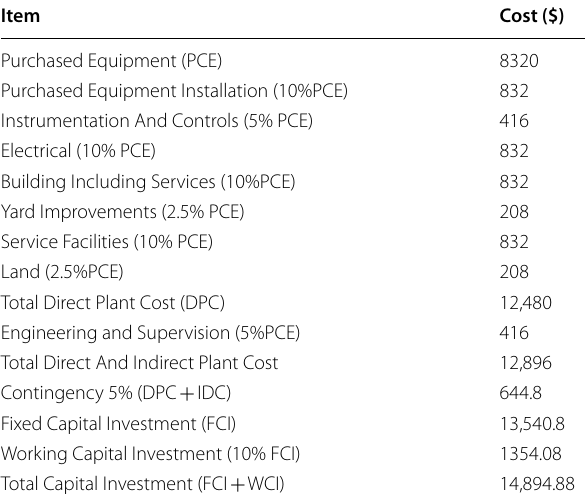
Table 5 Breakdown of fixed capital investment items for membrane production using batch casting